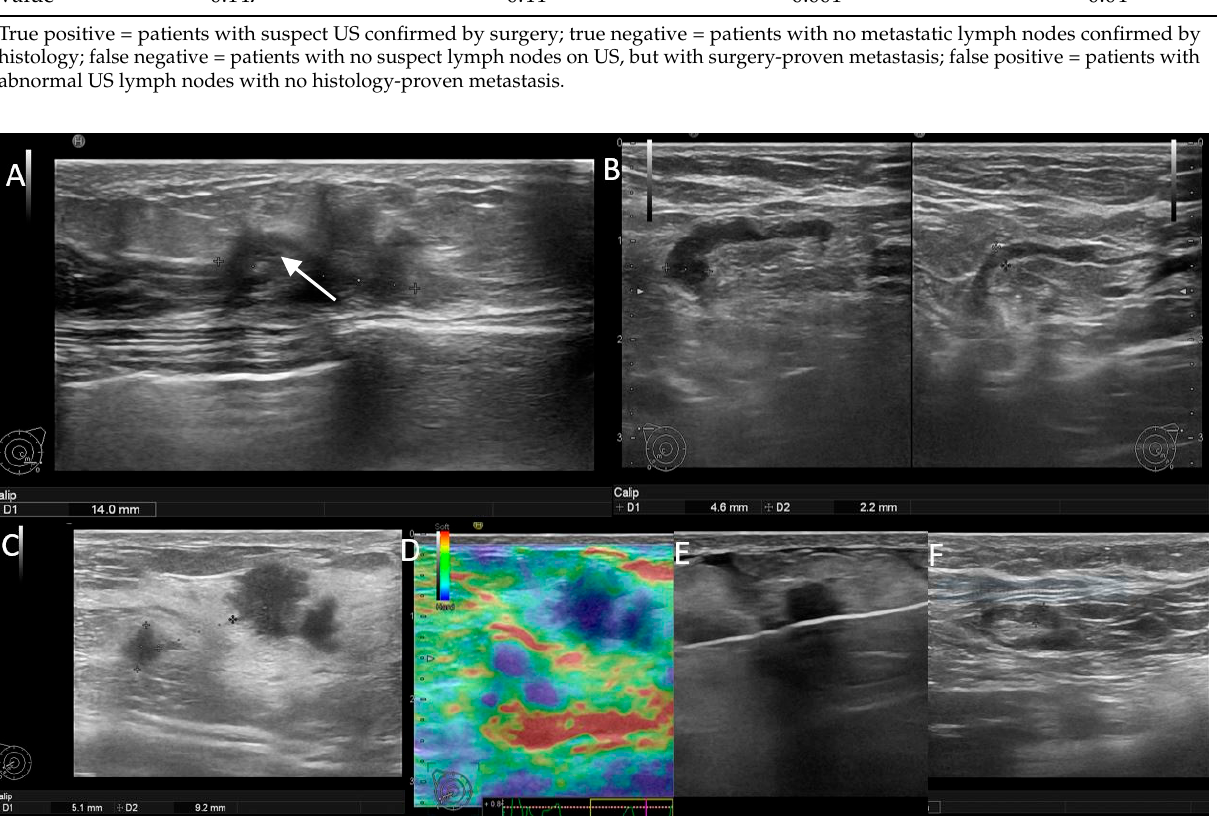
Figure 2. ( A , B ) Patient with negative genetic testin-unifocal BIRADS 5 mass and positive axillary US. There is an ipsilateral lymph node with cortical thickness up to 4.4 mm (white arrow), compared to the contralateral node, which has only 2.2 cortical thickness. ( C – F ) Patient with BRCA2 mutation-bifocal BIRADS 5 masses and negative axillary US. There is an ipsilateral node with fatty hilum and a thin cortex of 2